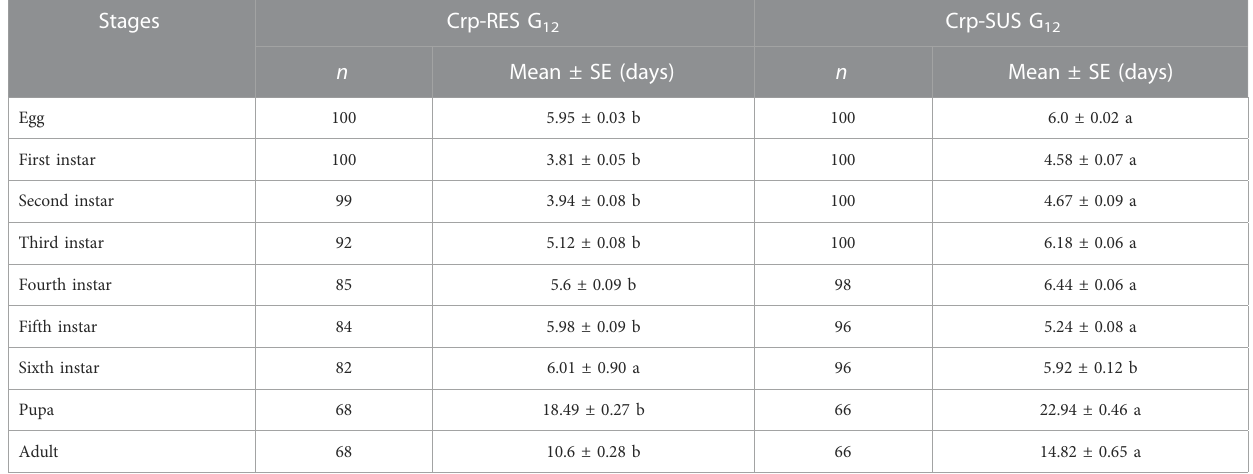
TABLE 3 Developmental time durations of various life stages of the Crp-RES G 12 and Crp-SUS G 12 strains.